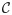
A description of MinPPI and MinPPI0.(A) An example of MinPPI. MinPPI corresponds to determining the minimum number of additional interactions starting with known PPI (a set of edges among proteins) data. For example, if a family of protein complexes C consisting of C1, C2 and C3 where the total number of proteins is 7 and known PPI data are given as an input data, the objective is to find the minimum number of additional PPIs required to describe interactions in all given protein complexes such that all proteins belonging to each complex Ci (i = 1, 2, 3) must be connected. Since an initial PPI network has 3 edges and one protein complex overlaps with other protein complexes, the resulting graph contains 7 edges. (B) An example of MinPPI0. MinPPI0 corresponds to the determination beginning with the set of known PPIs is empty. For example, if a family of protein complexes C composed of C1, C2 and C3 and known PPI data with no edge are given as an input data, the objective is to find the connected graph which has the minimum number of PPIs such that all proteins belonging to each complex Ci (i = 1, 2, 3) must be connected. Since a given PPI network has no edges and one protein complex overlaps with others, the number of additional edges is 6.